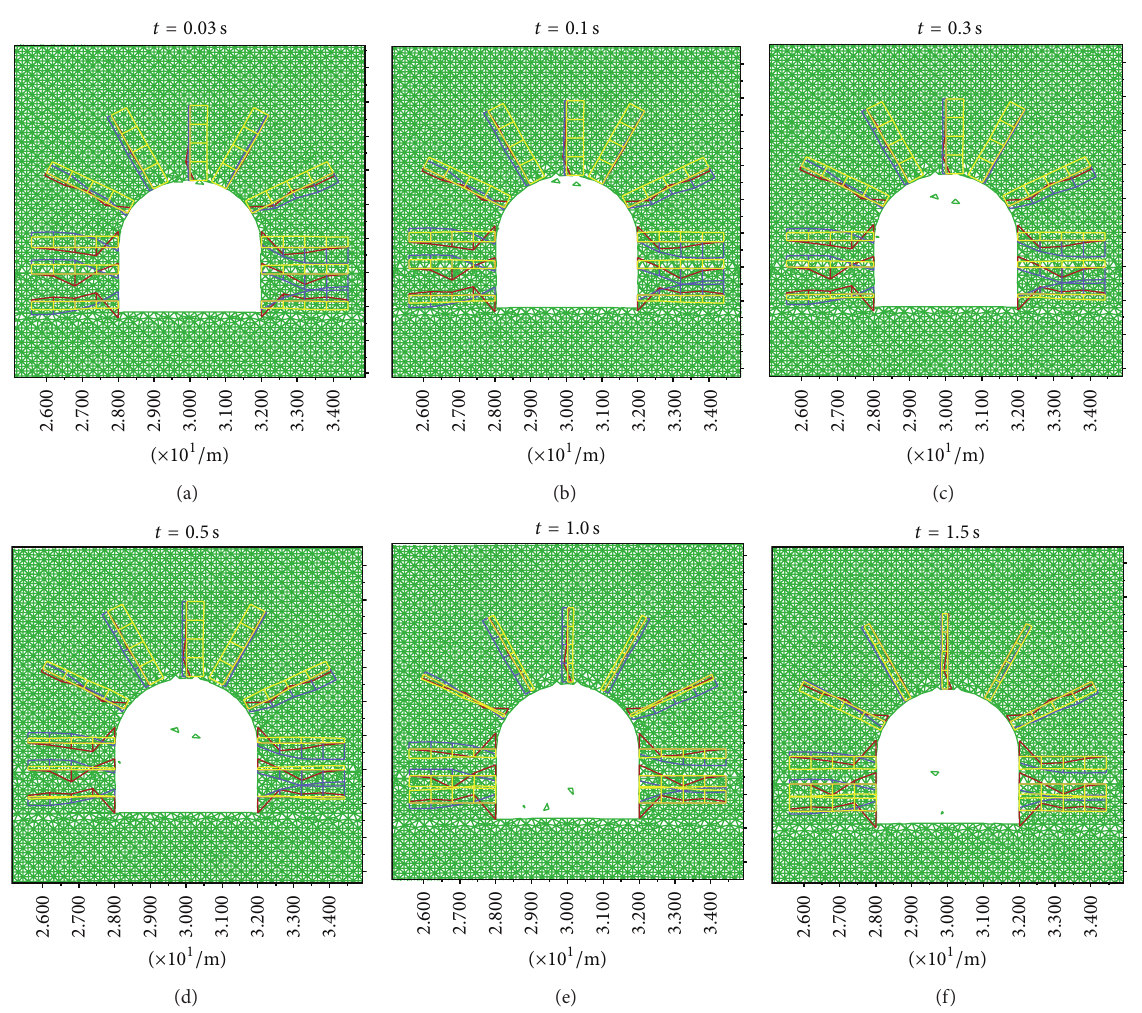
Figure 4: The disappearance of rockburst failure of roadway with bolt